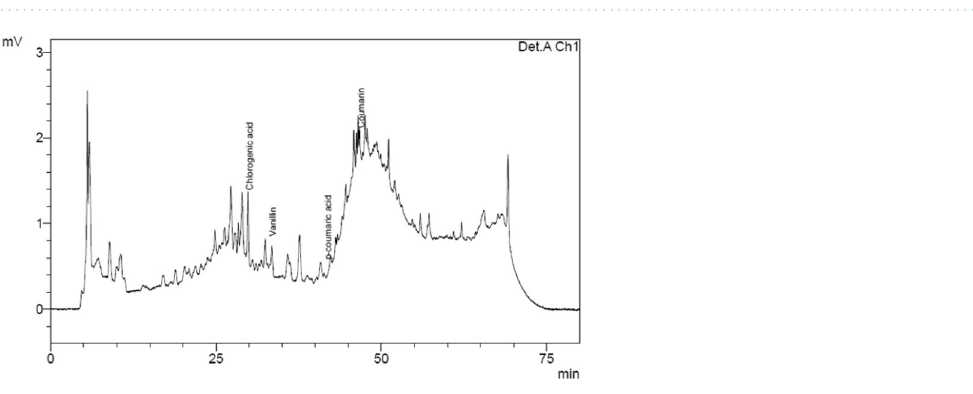
Figure 6. VHP sugar